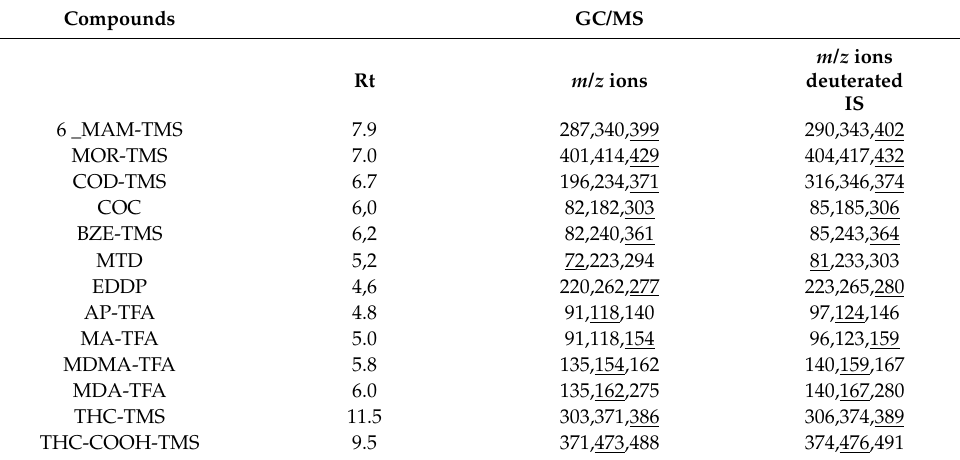
Table 1. Retention time (Rt), monitored ions ( m/z ) for analytes under investigation and deuterated internal